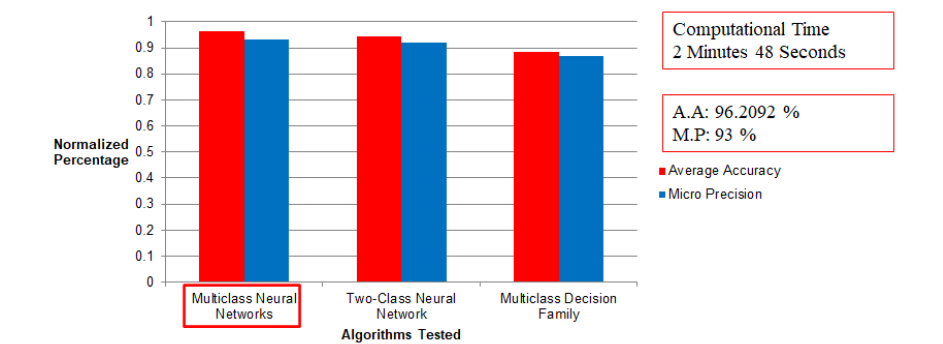
Figure 11. Multi-class classification model results for normal